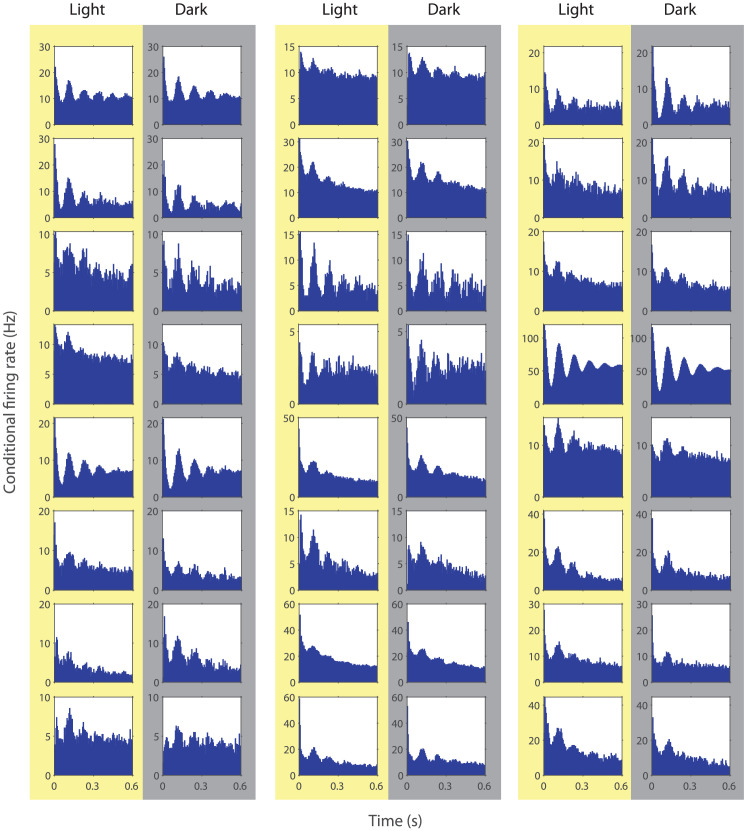
Spike time autocorrelograms of randomly picked 24 theta rhythmic neurons showing theta rhythmic spiking during the light and dark condition.